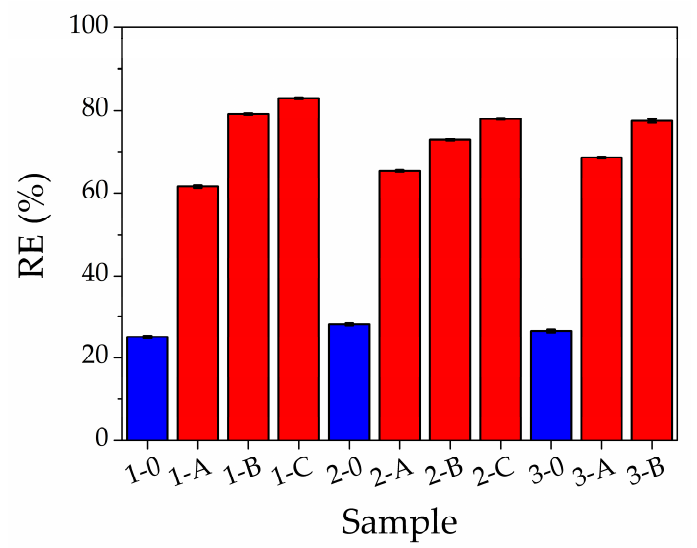
Figure 2. Removal efficiency as a function of filter composition after the filtration of a 1500 ppm of Pb(II) solution. Red bars represent the filters with AgNCs-PMAA, while blue bars correspond to those without AgNCs.